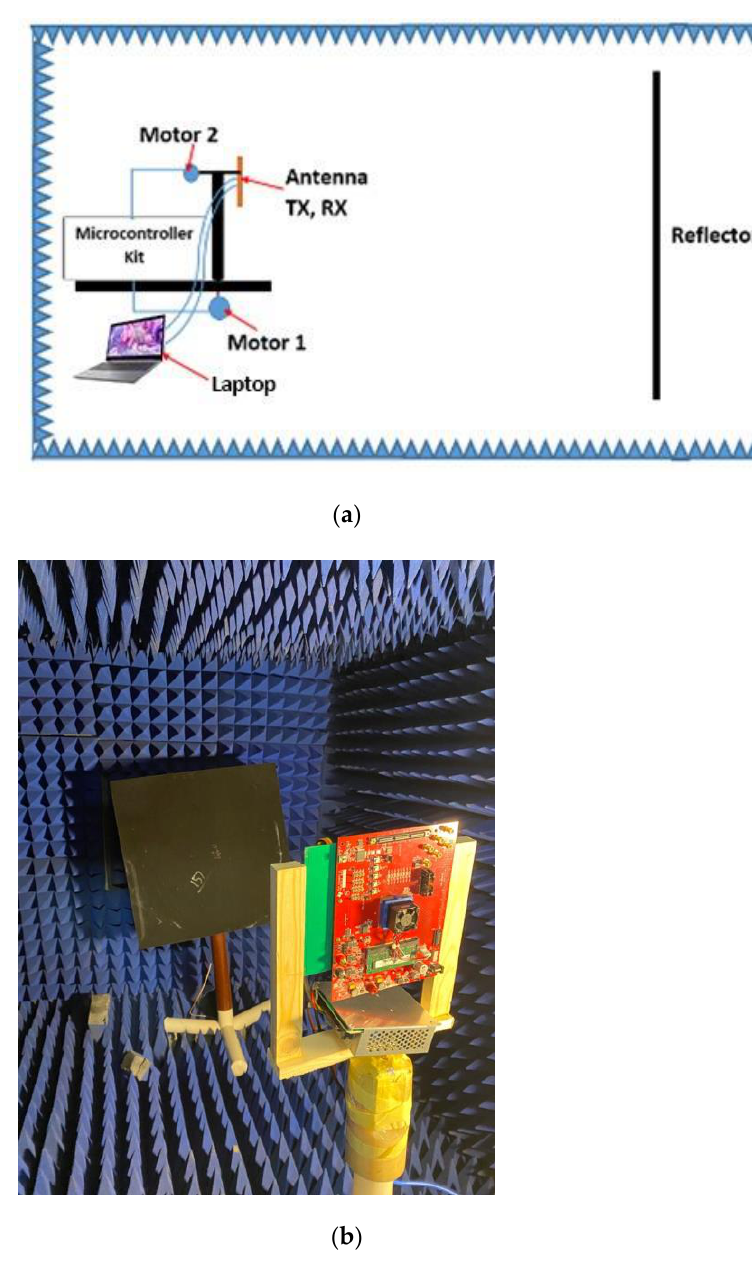
Figure 17. Setup system for VAA measurements: ( a ) proposed measurement system; ( b ) photo inside anechoic chamber.